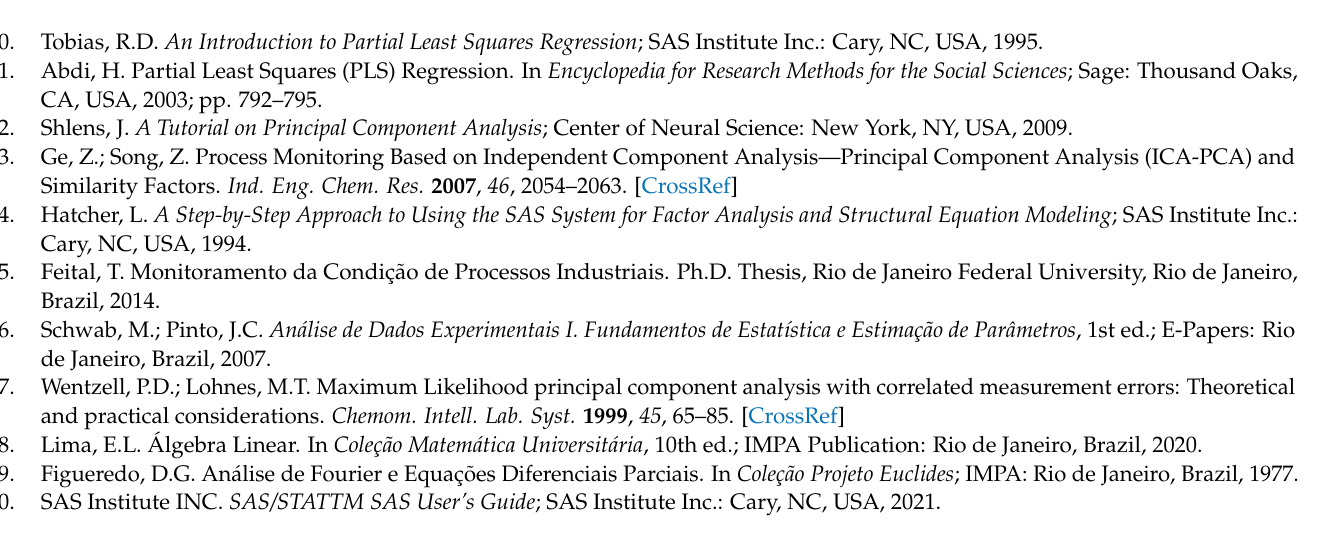
Figueredo, D.G. An á lise de Fourier e Equaç õ es Diferenciais Parciais. In Coleç ã o Projeto Euclides ; IMPA: Rio de Janeiro, Brazil, 1977.